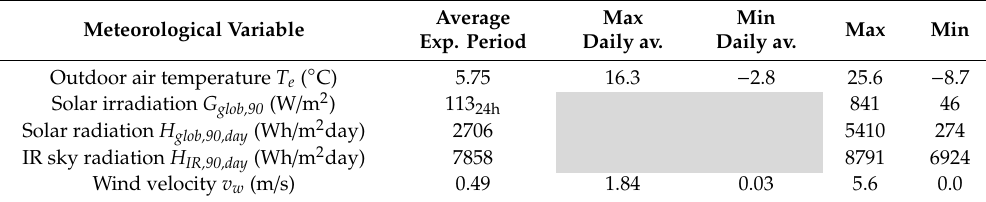
Table 1. Average and extreme values of meteorological variables during the duration of the experiment.